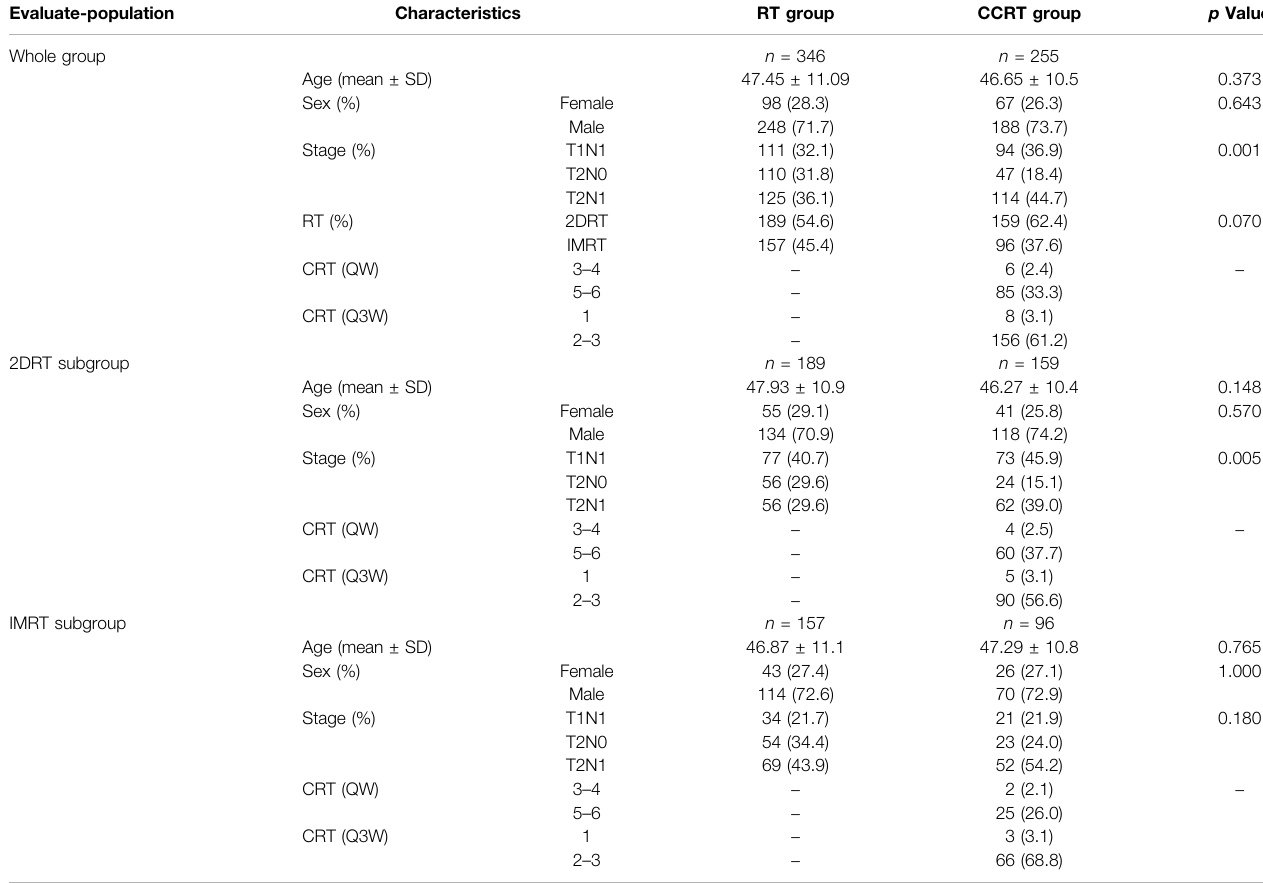
TABLE 1 | Baseline characteristics.